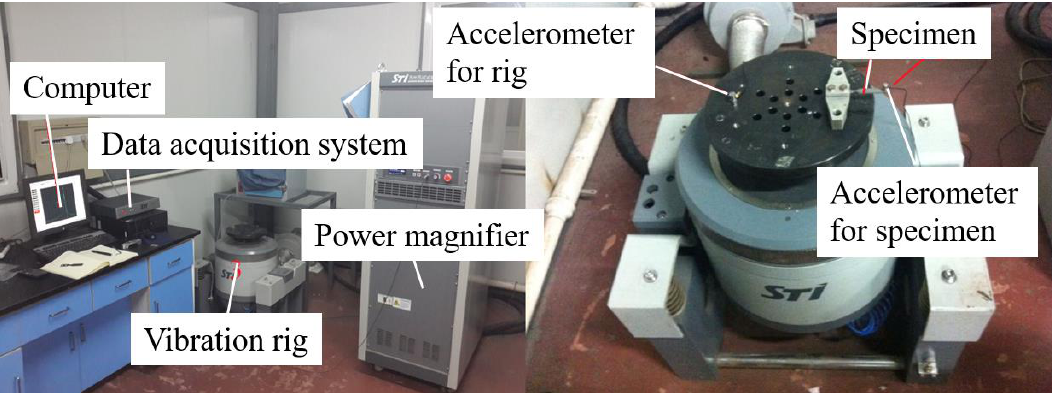
Figure 2. Configuration of vibration fatigue test.